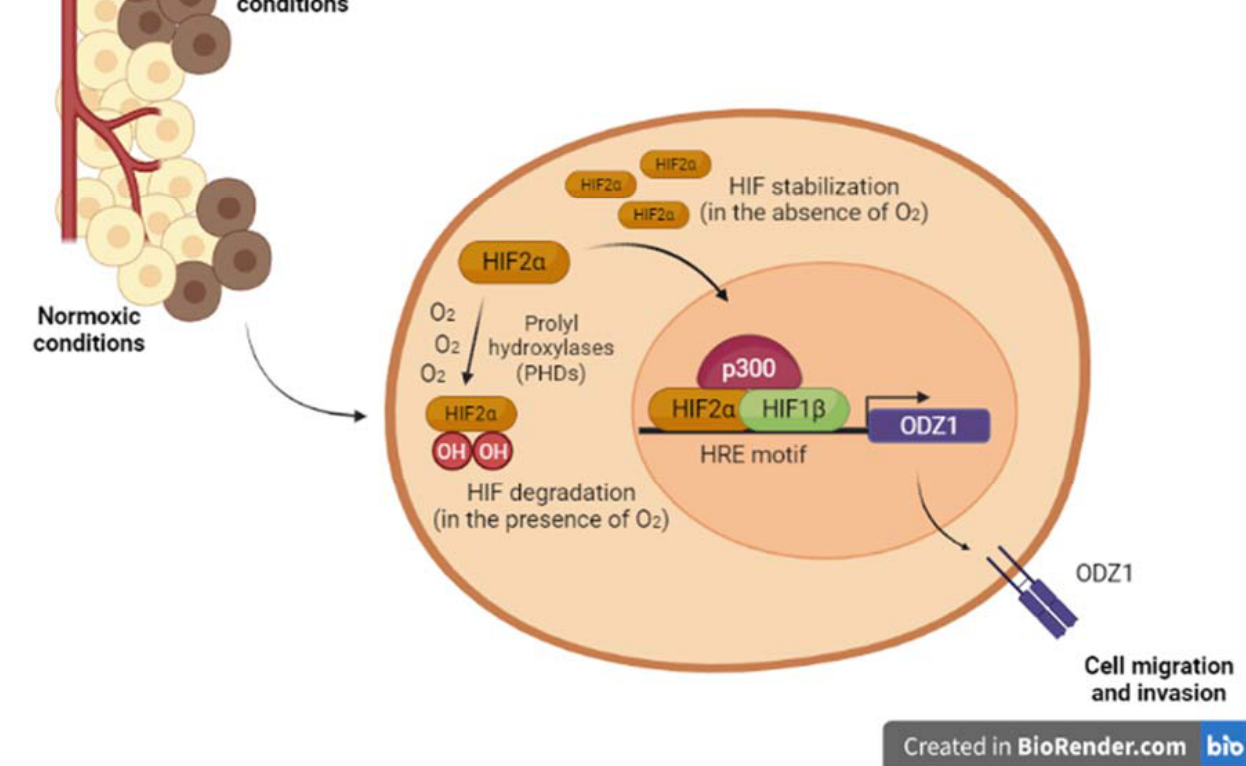
Figure 2. HIF2 α -ODZ1 gene expression pathway. HIFs are heterodimeric proteins, composed of alpha ( α ) and beta ( β ) subunits. In normal conditions, HIF α is subjected to ubiquitination and proteasomal degradation. However, under hypoxia, HIF is stabilized and translocated to the nucleus. In the nucleus, HIF α (HIF1 α , HIF2 α , or HIF3 α ) dimerizes with HIF1 β and the heterodimer binds to hypoxia-response element (HRE), a specific sequence (RCGTG) located within the promoter of target genes, including ODZ1, inducing their expression [70].